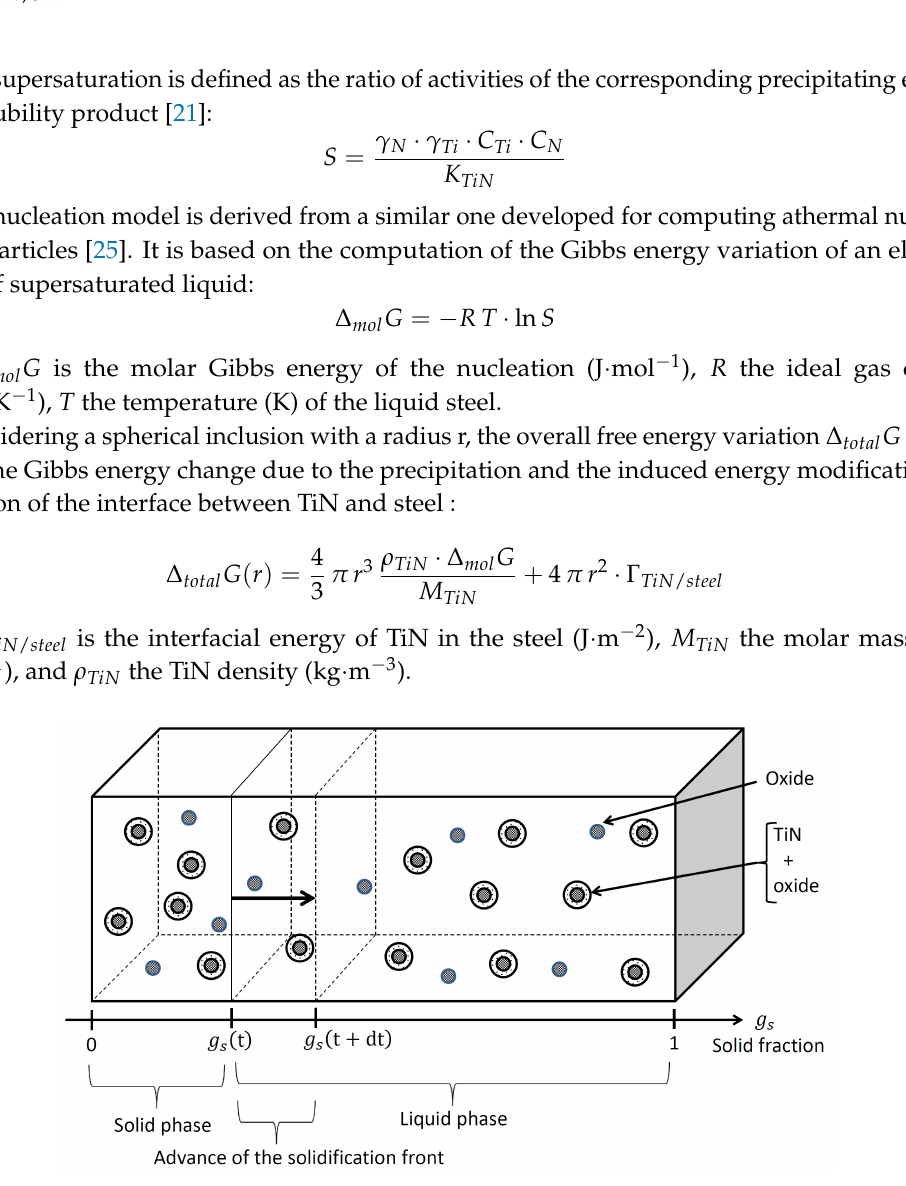
Figure 3. 0D system